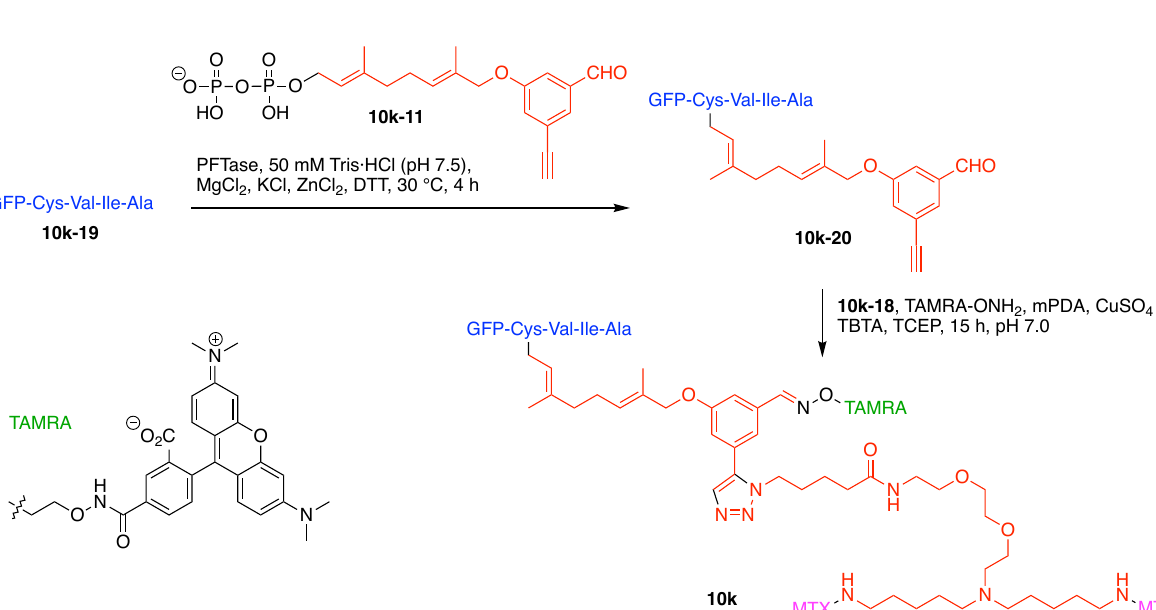
Figure 52. Rational assembly of GFP, TAMRA and azido-bis(MTX) on a benzene scaffold.